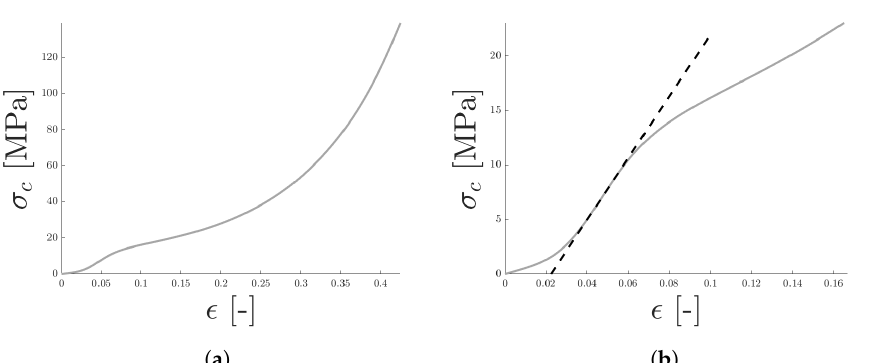
Figure 13. A typical loading response for uniaxial compression is seen in panel ( a ). The initial, nonlinear contact response was removed by extrapolating, using the equivalent Young’s modulus as illustrated in panel ( b ).